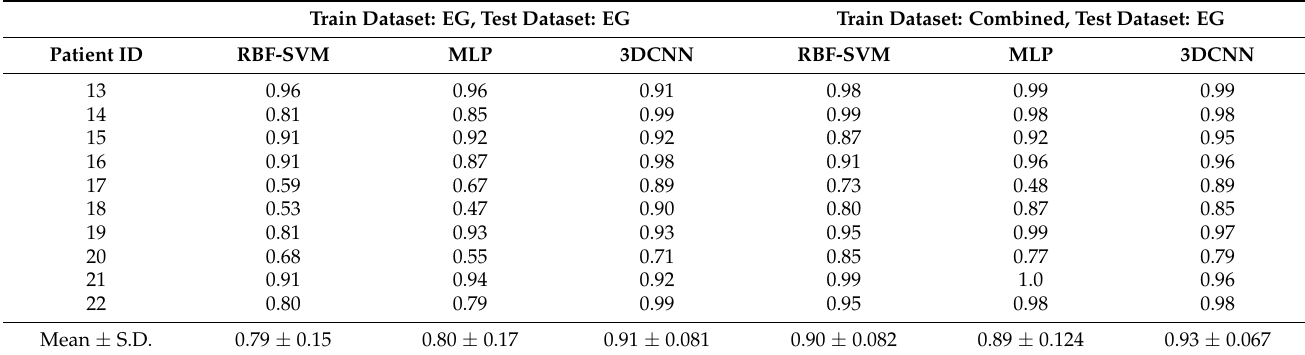
Table 4. ROC-AUC performance of different models evaluated on the esophagogastric (EG) dataset. Train Dataset: EG, Test Dataset: EG Train Dataset: Combined, Test Dataset: EG